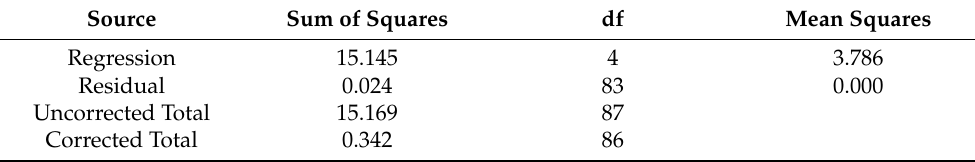
Table 6. ANOVA of the PLP Regression.